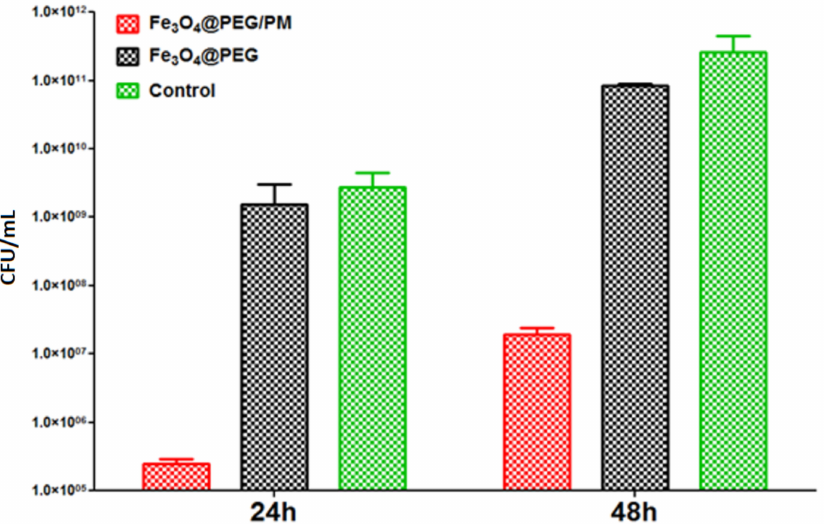
Figure 9. Evaluation of biofilm development after 24 and 48 h of incubation in the presence and absence of PEG-based thin film for S. aureus strain.